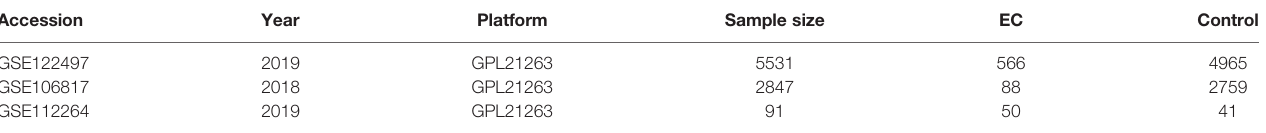
TABLE 1 | miRNA microarray data sets used in this study. Accession Year Platform Sample size EC